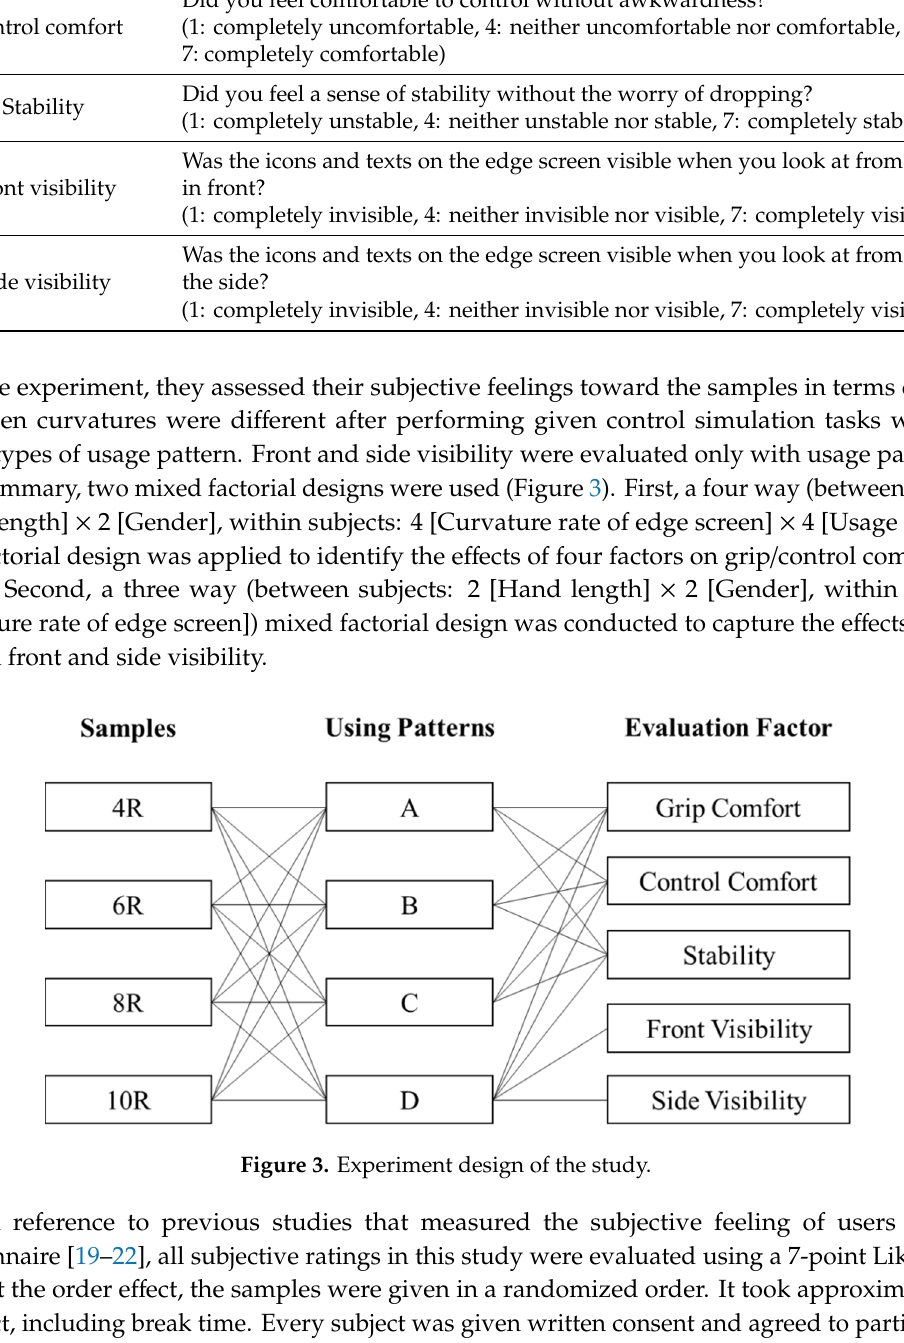
Table 2. Evaluated subjective feelings and their description.